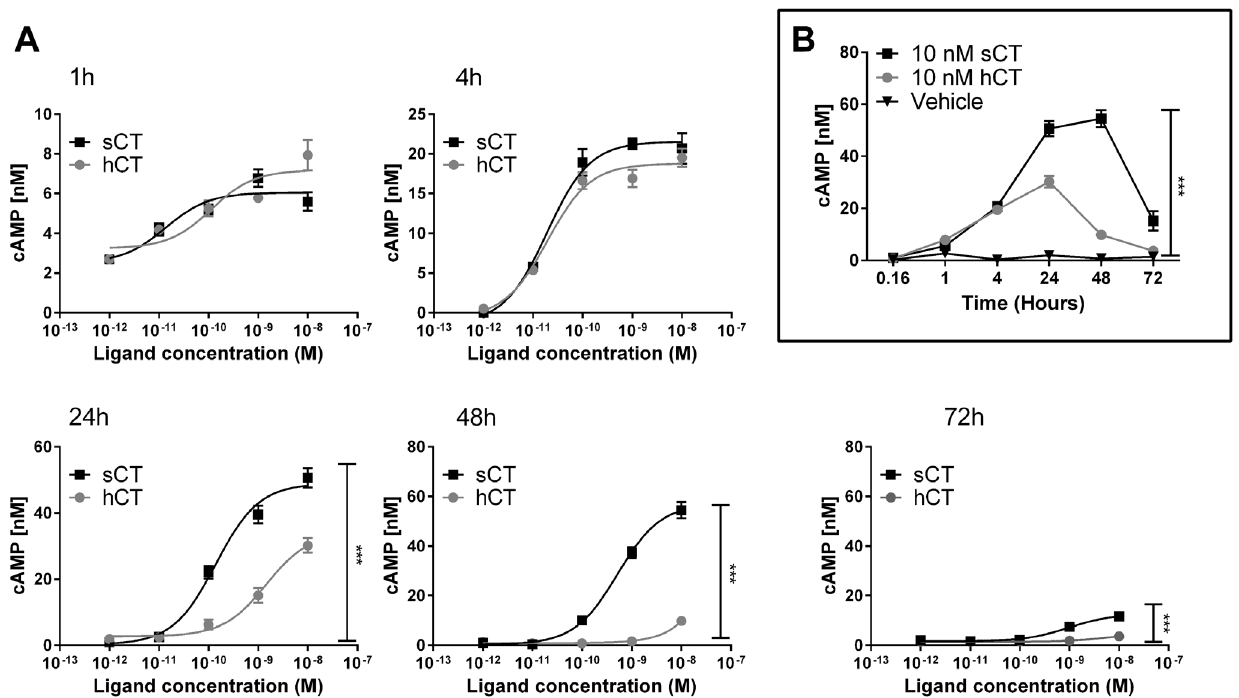
Figure 2. Difference in CT (a) R -mediated cAMP response by prolonged continuous hCT and sCT stimulation. A) cAMP production as a function of ligand concentration as U2OS CALCR cells were stimulated with sCT or hCT at a dose range of 10 pM to 10 nM for a prolonged period of time, ranging from 1, 4, 24, 48 to 72 hours. Ligands and medium were only added during the initiation of the experiment. Assays were conducted without IBMX in the medium to assess time dependent cAMP production. B) Single dose of 10 nM sCT, 10 nM hCT and Vehicle shown in (A) plotted as a function of time. Asterisk (*) indicate significant difference between AUC sCT and AUC hCT, p , 0.05 was considered to be significant. * =p , 0.05, ** =p , 0.01, *** =p , 0.001. Data are shown as mean 6 SEM and representative of three individual conducted experiments using five replicates.